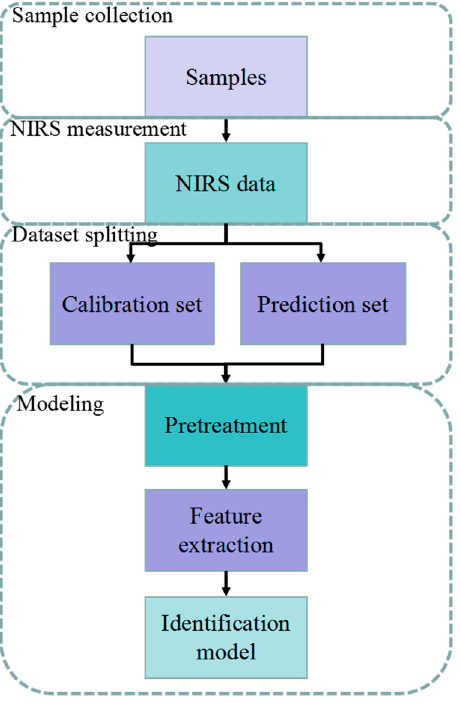
Figure 2. Process of the qualitative analysis by near infrared spectroscopy (NIRS).